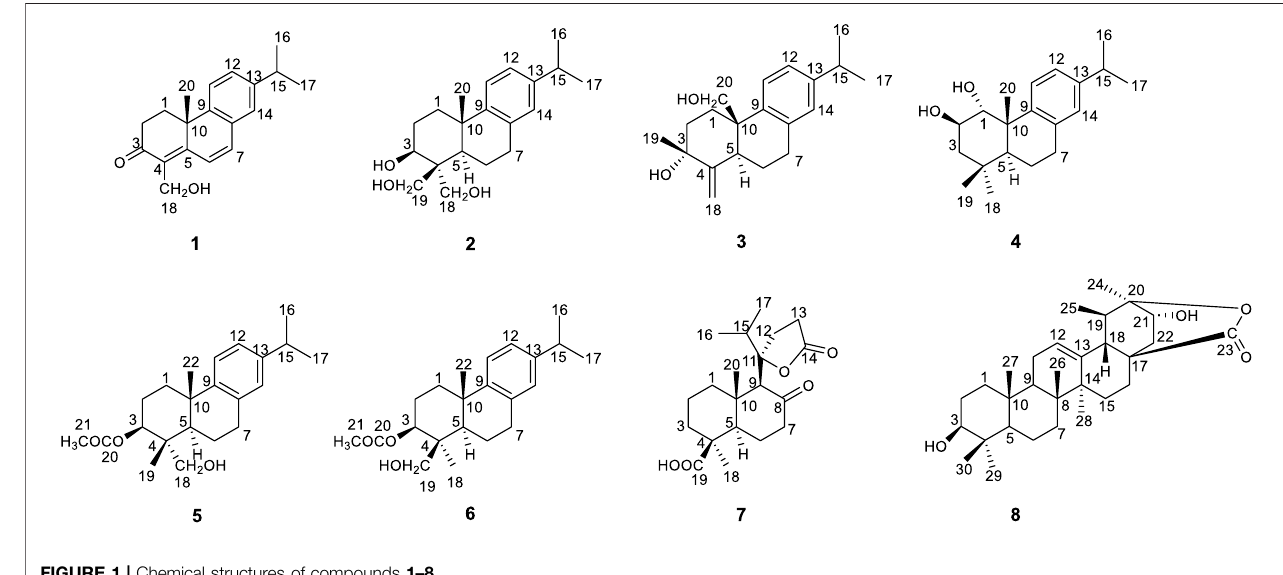
FIGURE 1 | Chemical structures of compounds 1 – 8